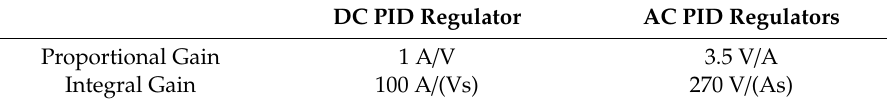
Table 3. Proportional–Integral–Derivative (PID) regulator parameters.